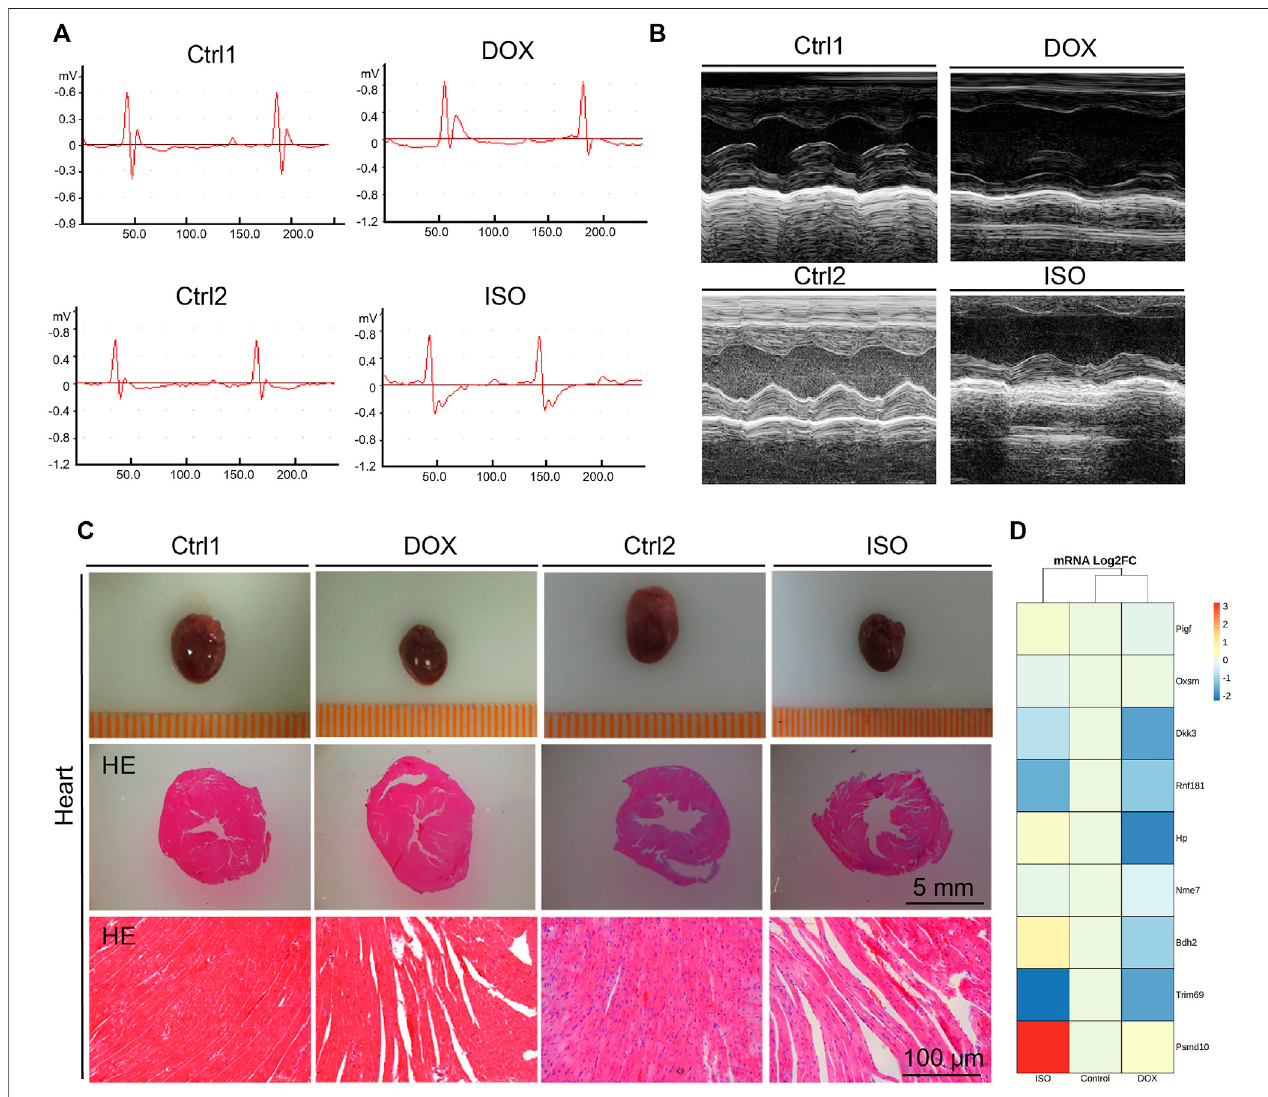
FIGURE3| Identi fi cation andvalidationofthe coronaryartery disease (CAD)causal genes. (A , B) Diagram representing mouse ECG (A) and echocardiography (B) attheendpointofdoxycycline(DOX)orisoproterenol(ISO)treatment. (C) RepresentativepicturesoftheheartmorphologyandHEstaining. (D) Heatmapgeneratedfrom the DNA-seq expression pro fi les showing the Log2FoldChange of the expression of 9 CAD causal genes from the control and ISO- and DOX-treated cardiotoxicity mouse models. (D , E) Heart sections and immunohistochemistry (IHC) staining of RNF181 in the control and DOX- and ISO-treated mice. (F) Statistical analysis results of the immunostained area of RNF181 (percentage). (G) CAD causal genes substantially perturbed by DOX were further con fi rmed by qRT-PCR. Signi fi cant threshold of p = 0.05.